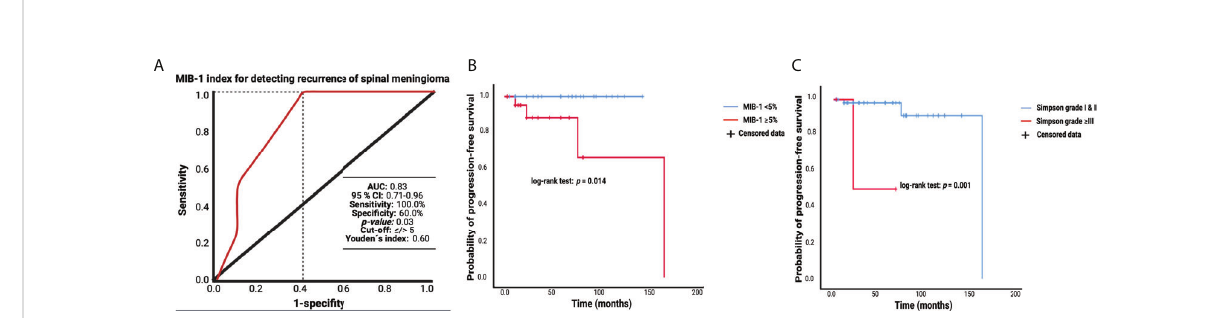
FIGURE 2 (A) Receiver-operating characteristic curve showing the MIB-1 labeling index in the prediction of progression of sporadic spinal meningiomas. The dashed line marks the identi fi ed optimum cut-off value. (B) Kaplan-Meier analysis of tumor progression probability strati fi ed by “ MIB-1 ≥ 5% ” (red line) and “ MIB-1 < 5 ” (blue line). Vertical dashes represent censored data (constituting for progression-free at last follow-up) within the PFS curves. The time axis is right-censored at 200 months. (C) Kaplan-Meier charts of tumor progression probability strati fi ed by “ Simpson grade ≥ III ” (red line) and “ Simpson grade I & II ” (blue line). Vertical dashes represent censored data (constituting for progression-free at last follow-up) within the PFS curves. The time axis is right-censored at 200